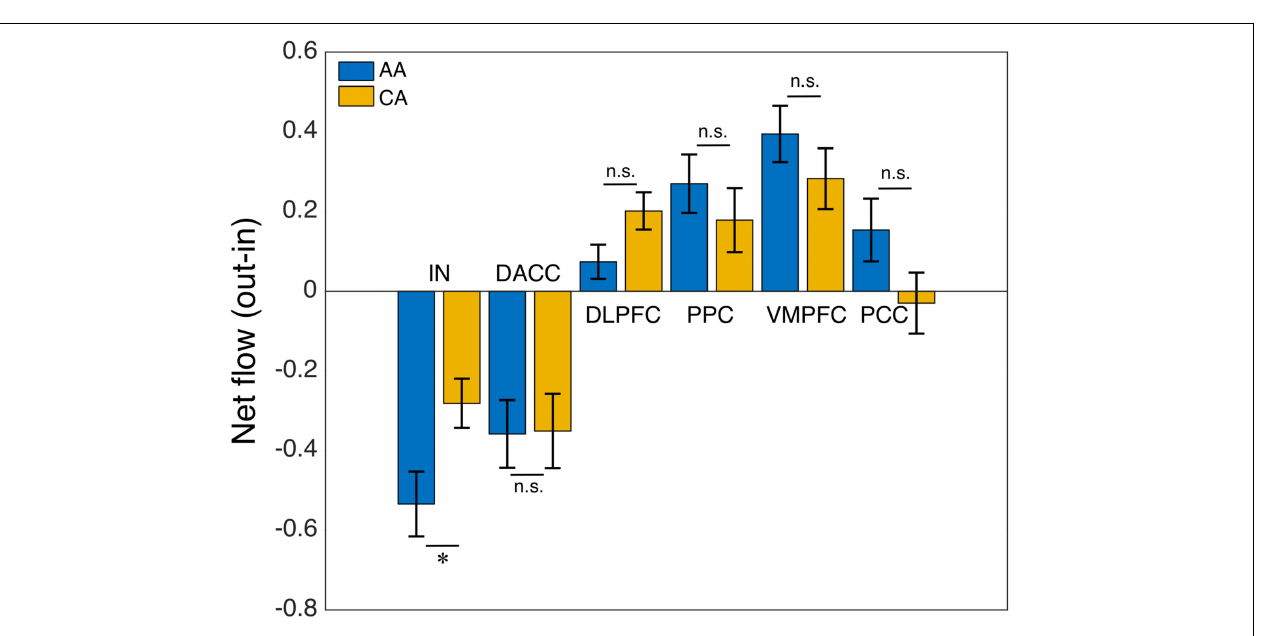
Frontiers in Aging Neuroscience |